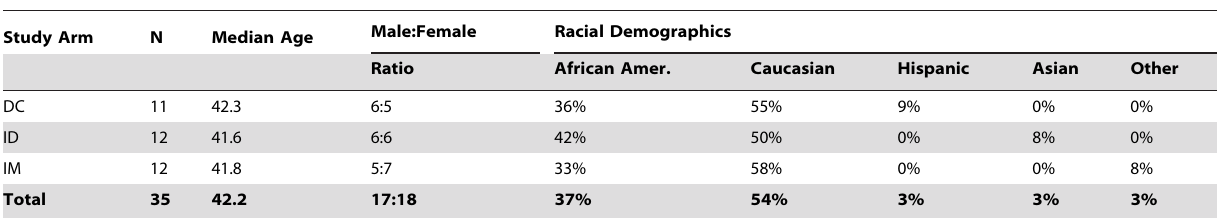
Table 1. Demographics of study